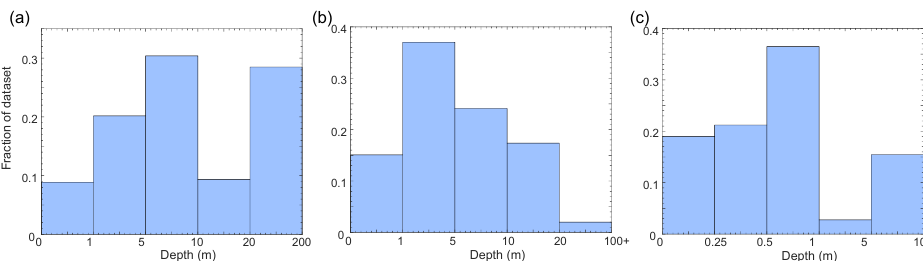
Figure 4. Histograms showing the fraction of the density dataset by mid-point sampling depths for (a) Antarctica, (b) Greenland excluding Summit Station, and (c) Summit Station.